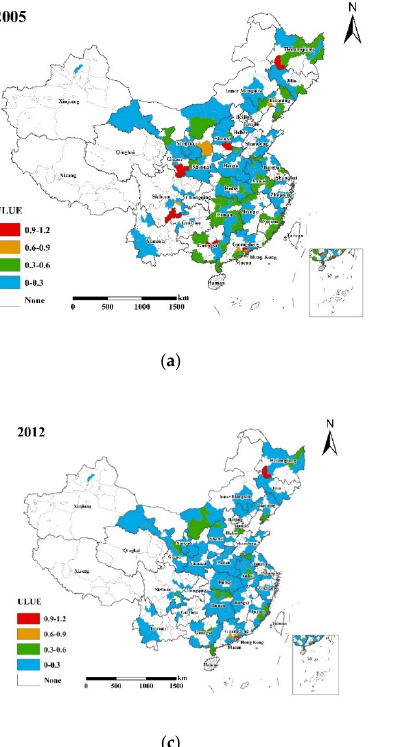
Figure 3. The time trend of the mean urban land use efficiency for the treatment and control groups.